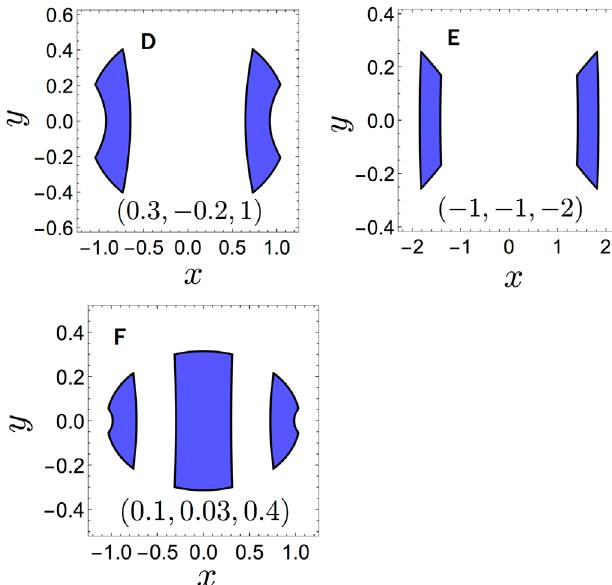
FIG. 13. Projections of three additional level set types, com- pleting the collection (A-G) begun in Fig. 4. In each figure, the numerical triple denotes ð H; I; τ Þ . A nonresonant orbit on such a level set densely fills one of its connected components. (D) Two connected components, not intersecting the branch cuts.